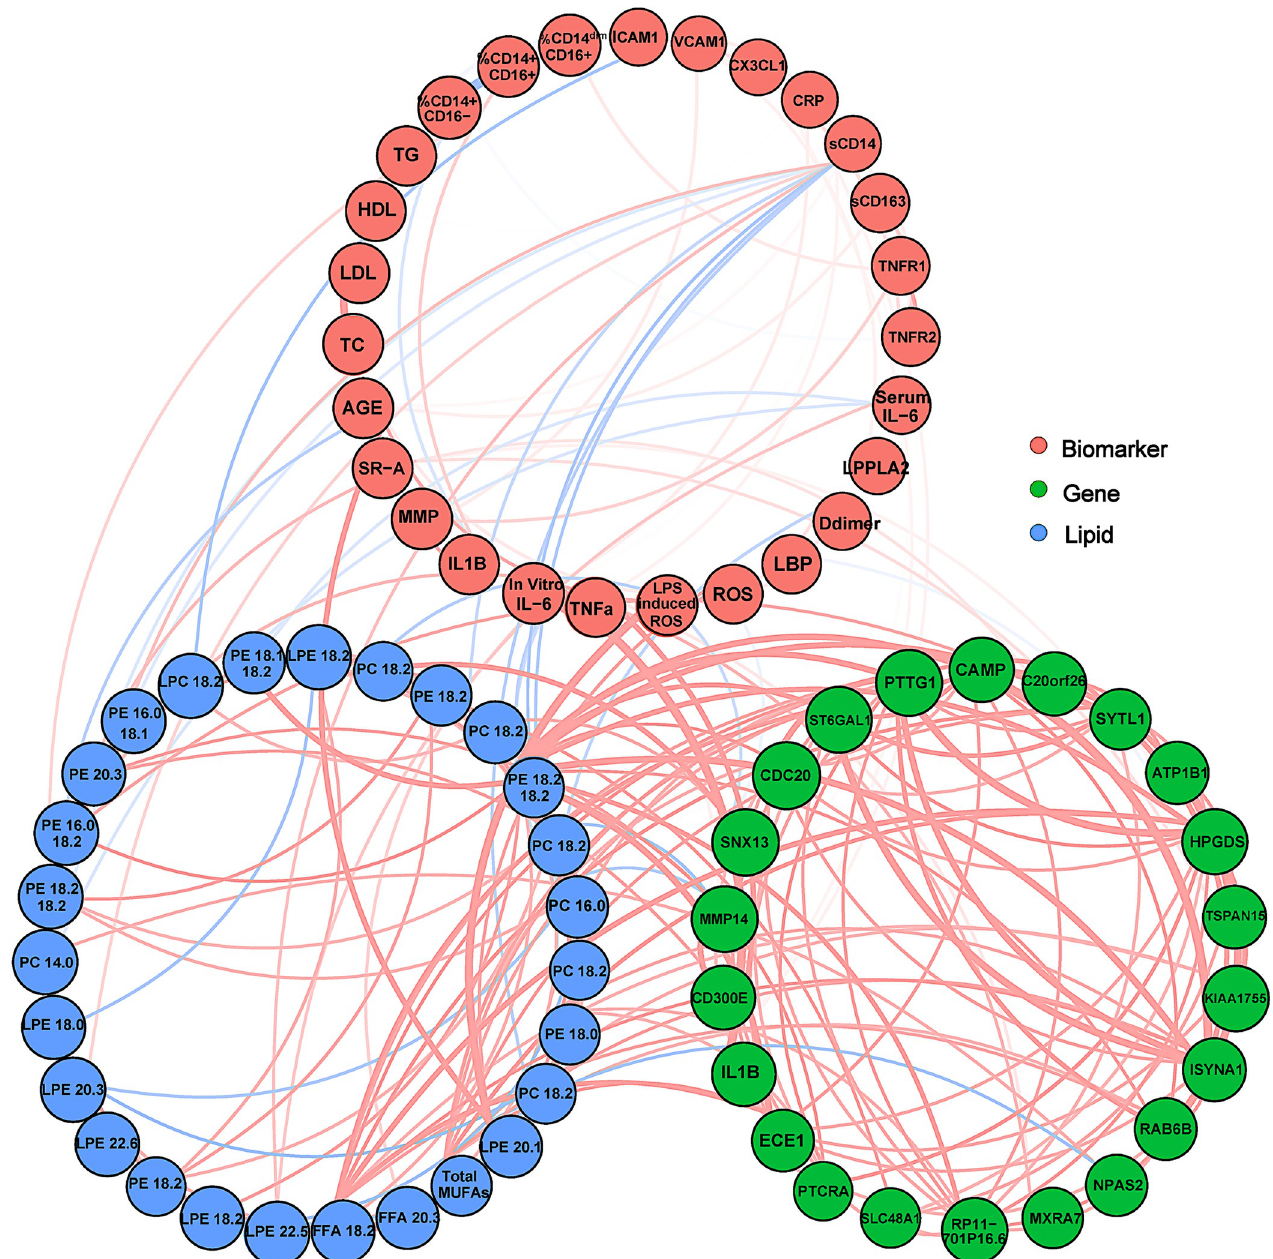
Fig 5. Transcriptomic, lipidomic and protein expression model. We performed linear regression to identify genes, lipids and proteins that are most highly predictive for all three data types. The most highly interactive genes and lipids are displayed as nodes, with edges representing Pearson correlations between genes and lipids, and genes and biomarkers, as well as PCCs for actual gene-gene correlations. Because the lipid and gene data was so highly interactive, only edges with p-value < 0.01 and have an r-value > 0.5 were shown for clarity.